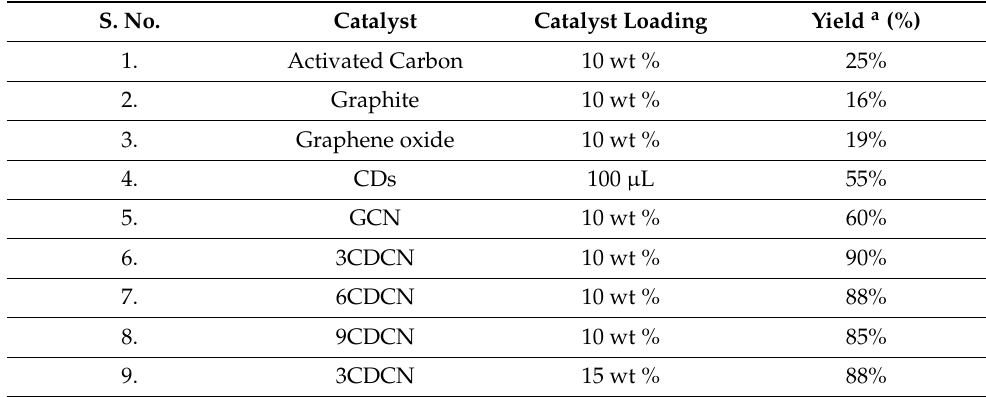
Table 1. The selection of photocatalysts. S. No. Catalyst Catalyst